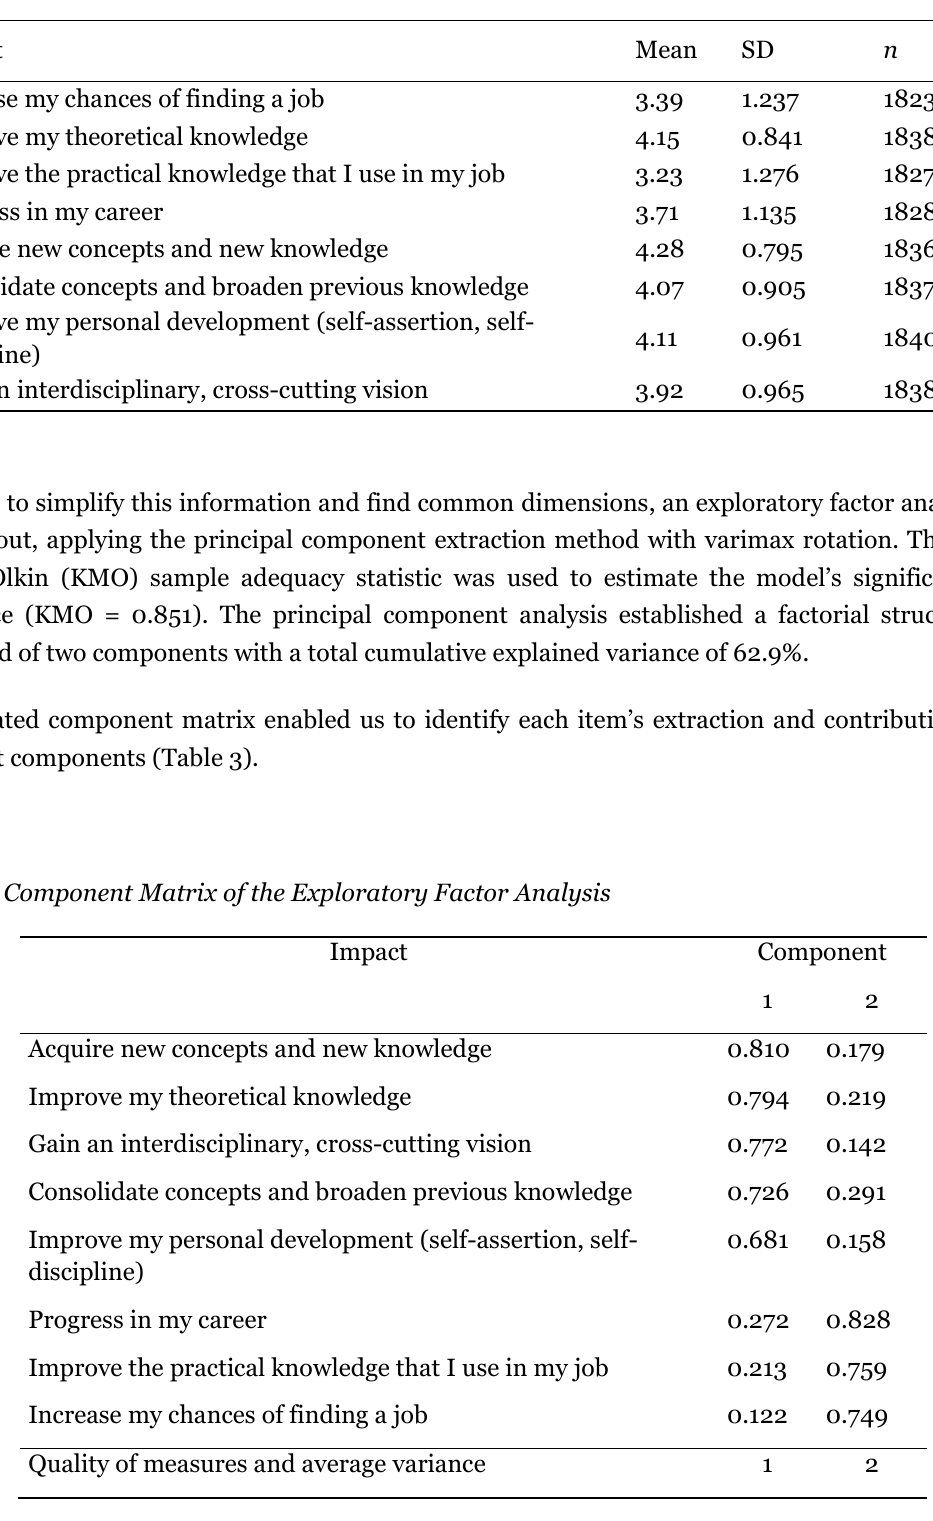
Respondents’ Perceptions of the Impact of Studying at UOC